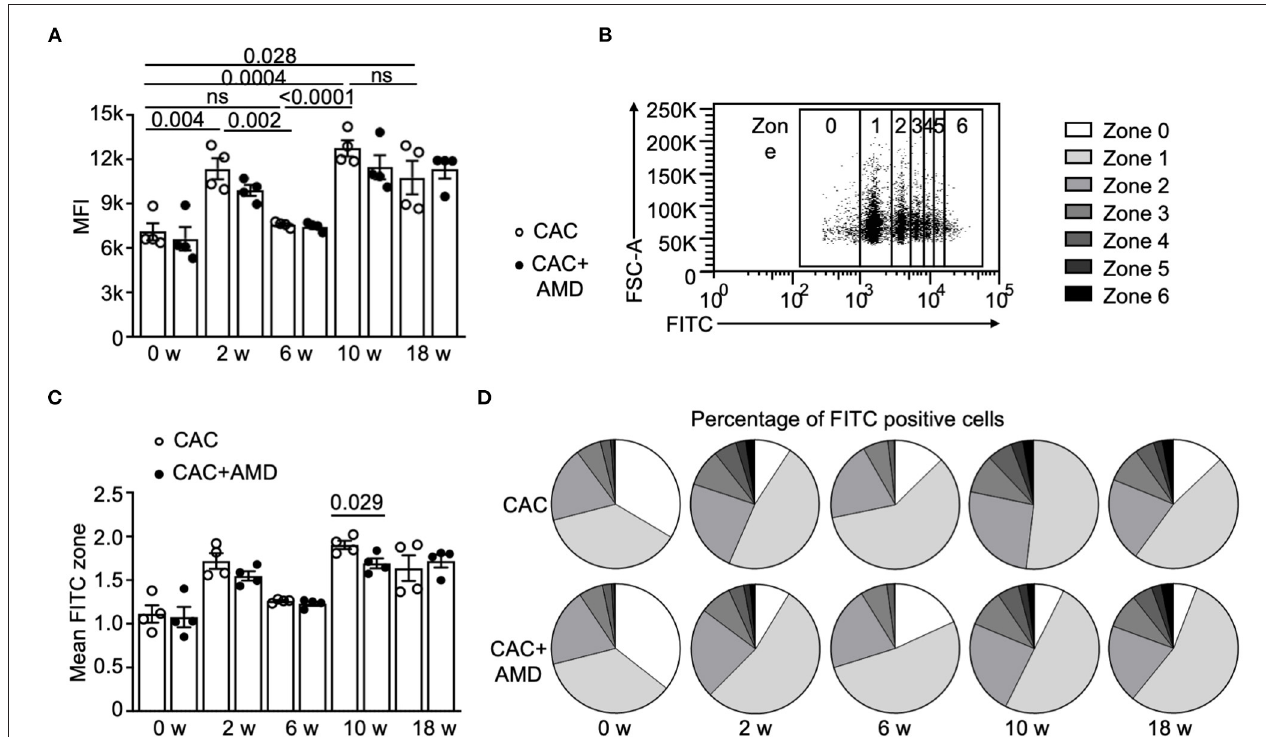
FIGURE 2 | The phagocytic function of PMs changed during colitis-associated tumorigenesis. (A) The flow cytometer measured the phagocytic activity of peritoneal macrophages (PMs) from two groups. Mean fluorescence intensity (MFI) of the pHrodo Green Zymosan Bioparticles phagocyted by macrophages was calculated and shown ( n = 4). (B) The gating strategy for macrophages with increased phagocytic functions was marked as 0-6 depending on the MFI value on FITC. (C) Mean FITC zone of PMs from two groups ( n = 4). (D) Percentage of PMs with different phagocytic functions from two groups in untreated mice and in mice from the 2 nd , 6, 10, and 18 th -weeks post-AOM/DSS induction ( n = 4). Individual data are shown as Mean ± SD. Statistical analysis was carried out using unpaired t